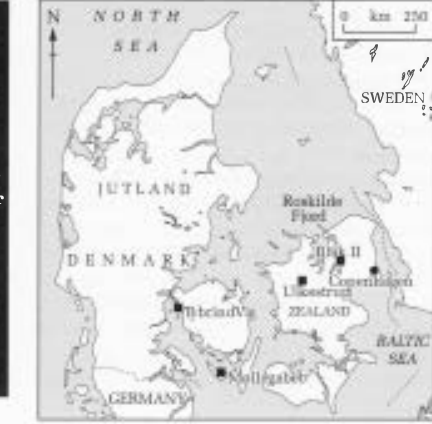
Figure 1 Denmark, showing the location of Mesolithic sites mentioned in the text. been found in the 1920s during dredging at exactly this location, gave a hint of what would be discovered during the excava­ tions that took place from 1990 to 1993. In 1990-91 a Mesolithic dugout canoe (made from the trunk of a lime tree, Tilia sp.) was excavated in a concentration of wooden stakes, deer antlers, flint axes, a few human bones, a large sheet of birch